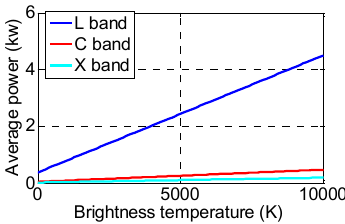
Figure 8. Average transmitted power requirement in the distributed RFI case.